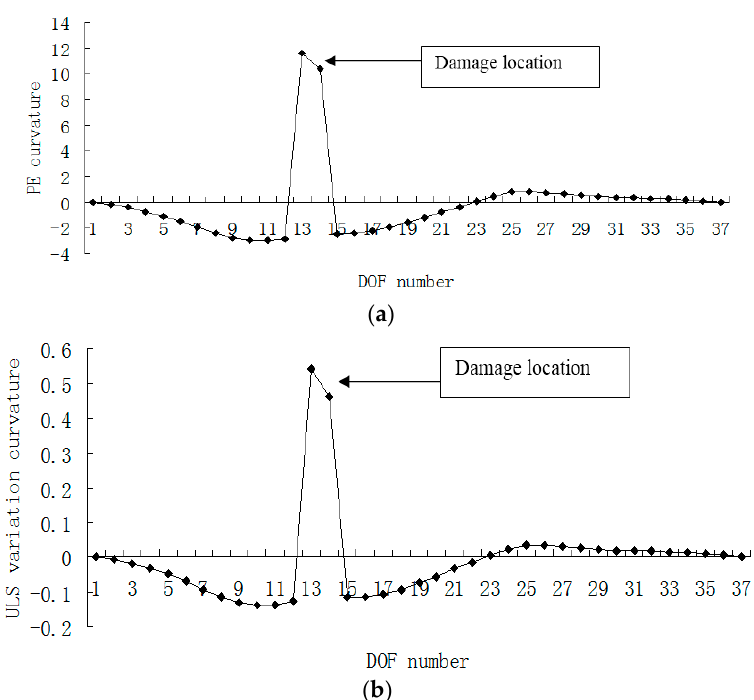
occurred in element 13(×10 − 4 ).